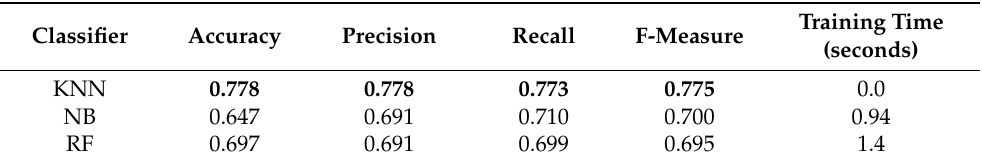
Table 9. Identification results of VGG-19-deep features obtained by minimizing (F6 and F7). Bold values signify the best